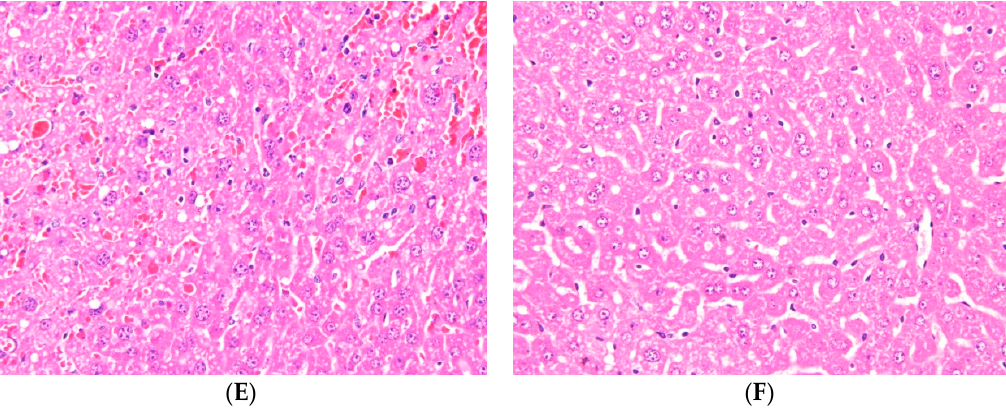
Figure 2. Ugonin M pretreatment alleviated acetaminophen (APAP)-induced liver injury in mice. ( A ) Control group; ( B ) APAP-only group: presence of severe centrilobular necrosis in the defined area (red oval), polymorphonuclear inflammatory infiltrates (black arrows), and vacuolated hepatocytes; ( C ) APAP + 600 mg/kg N-acetylcysteine (NAC) group; ( D ) APAP + 0.625 mg/kg Ugonin M group; ( E ) APAP + 1.25 mg/kg Ugonin M group; ( F ) APAP + 2.5 mg/kg Ugonin M group. The figures demonstrate representative views of hematoxylin and eosin (H&E) stained liver tissue from each group. The original magnification: ×400.